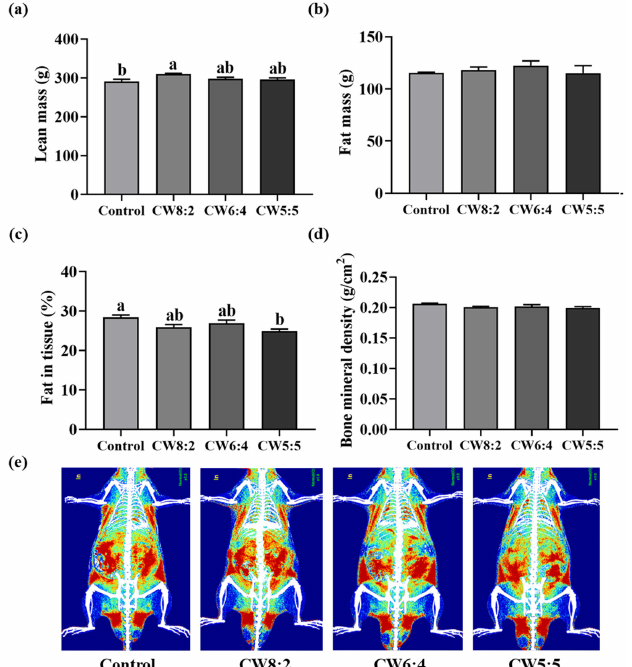
Figure 2. The body composition of the rats administered milk with adjusted casein to whey proteins ratio for eight weeks ( n = 6): ( a ) lean mass (g), ( b ) fat mass (g), ( c ) fat in tissue (%), ( d ) bone mineral density (g/cm 2 ), and ( e ) radiograph. Data are expressed as mean ± SEM. The values with different letters indicate significant differences at p < 0.05. CW, casein:whey proteins.